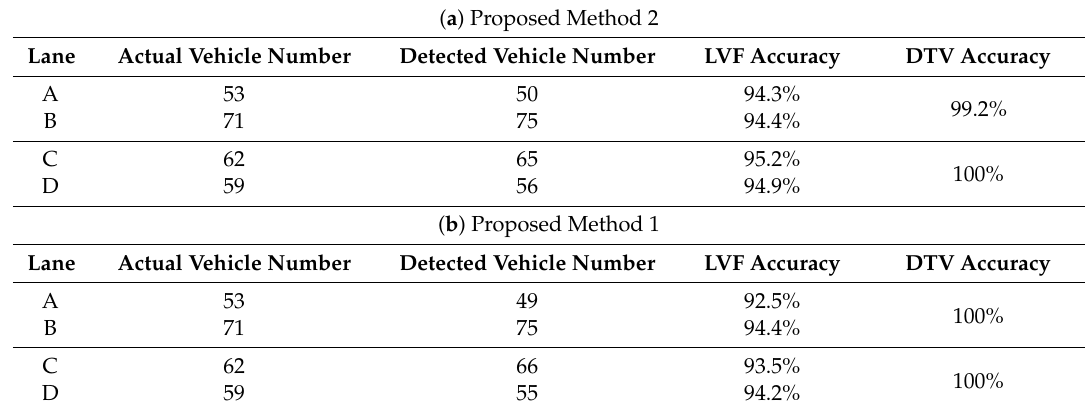
Table 9. Results of LVF and DTV detection during 12:40–12:50 PM (moderate traffic) using ( a ) proposed method 2 and ( b ) proposed method